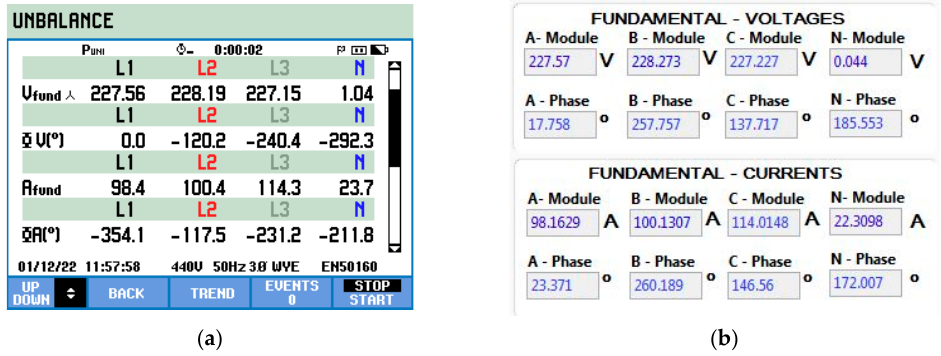
Figure 11. Complex RMS values of the line-to-neutral voltages and line currents: ( a ) measured by the Fluke 435 analyzer, and ( b ) calculated by Multisim, using LabVIEW.